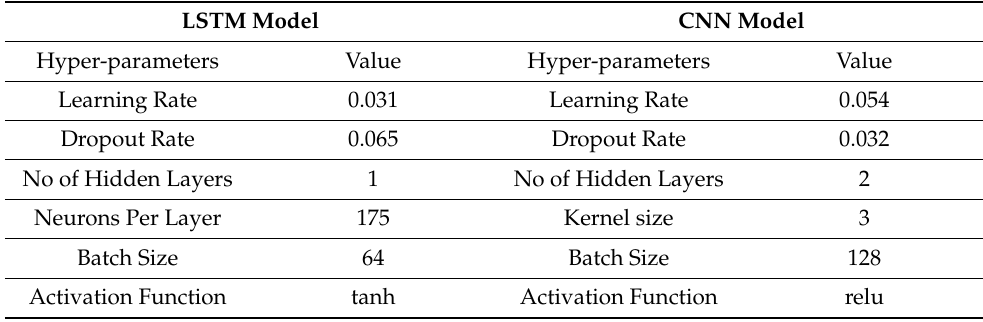
Table 3. Hyper-parameters used for Deep Learning Models.